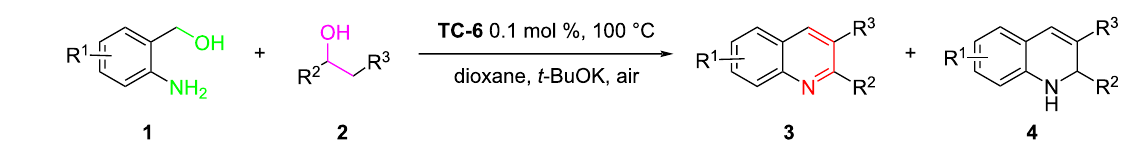
Figure 2: Cyclometalated iridium-catalyzed ADC reaction of o -aminobenzyl alcohols and secondary